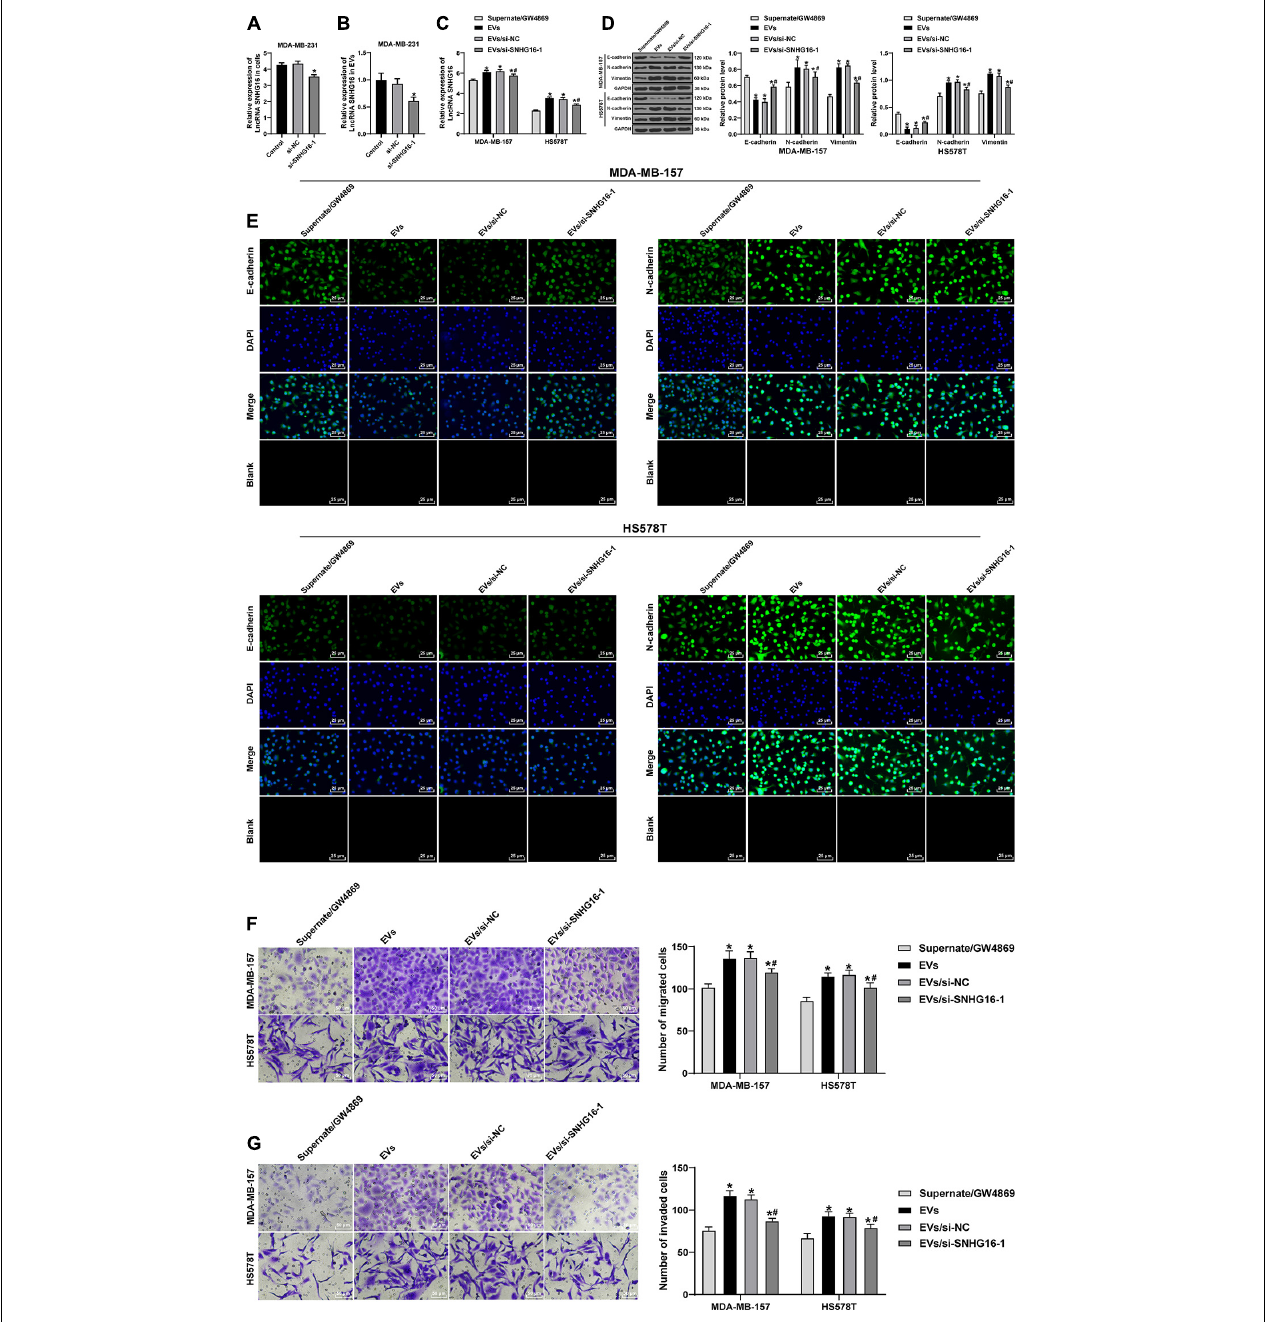
FIGURE 4 | BC cell-EVs promoted BC cell migration and invasion by carrying SNHG16. MDA-MB-231 cells were treated with si-SNHG16 or GW4869, and then EVs or supernatant was extracted and incubated with MDA-MB-157 and HS578T cells. (A) The expression of SNHG16 in MDA-MB-231 cells after transfection was detected using RT-qPCR, * p < 0.05 vs. control group. (B) The expression of SNHG16 in MDA-MB-231 cell-EVs after transfection was detected using RT-qPCR, * p < 0.05 vs. control group. (C) The expression of SNHG16 in MDA-MB-157 and HS578T cells after GW4869/Supernatant or EVs treatment was detected using RT-qPCR. (D) The levels of E-cadherin, N-cadherin, and vimentin were detected using Western blotting. (E) The levels of E-cadherin and N-cadherin were detected using immunofluorescence ( × 200). (F,G) The migration and invasion abilities of MDA-MB-157 and HS578T cells were measured using Transwell assays. Cell experiment was repeated three times. Data were presented as mean ± standard deviation. Data in A, B, and D were analyzed using one-way ANOVA, and data in C, F, and G were analyzed using two-way ANOVA, followed by Tukey’s multiple comparison test, * p < 0.05 vs. control group, # p < 0.05 vs. EVs/si-NC group.